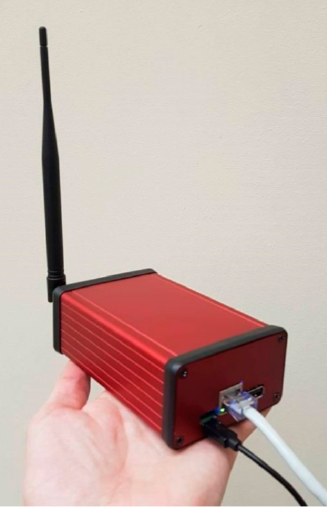
Figure 4. View of LoRa gateway: LORANK-8 (own source).